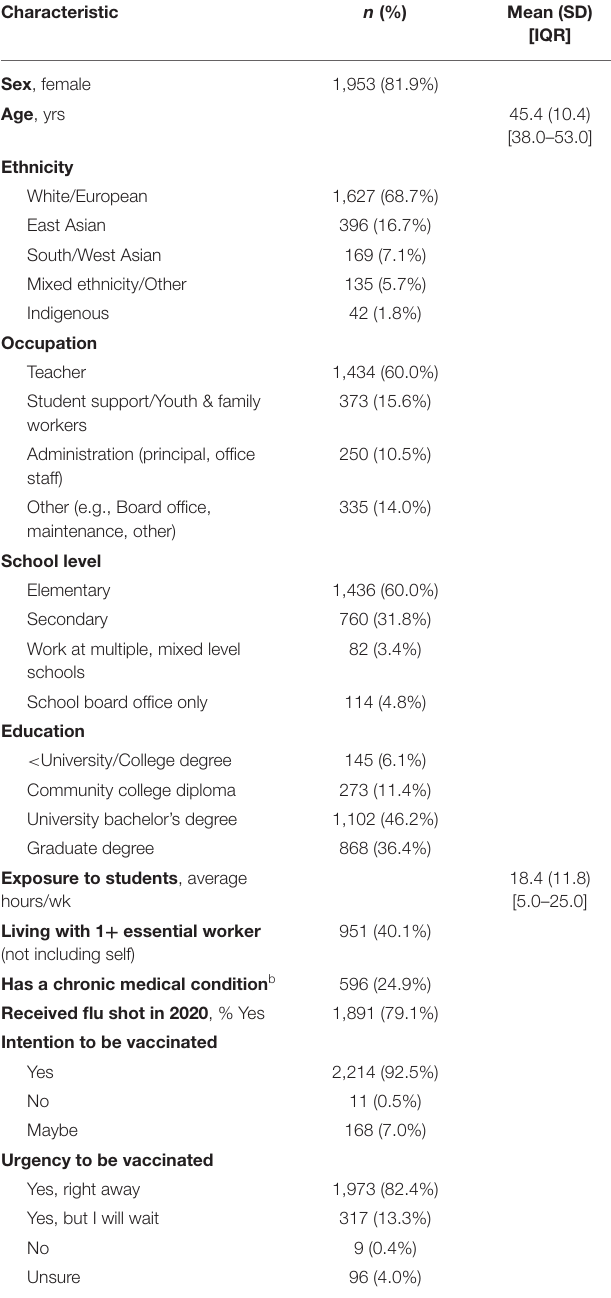
TABLE 1 | Characteristics of participating school district staff ( n = 2,393) a